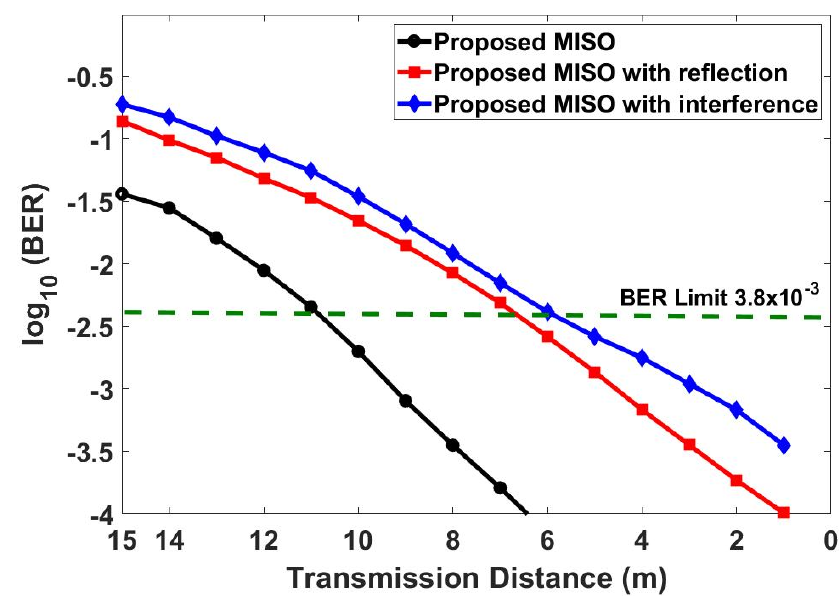
Figure 8. BER performance using 4 × 1 MISO processing for the cases when the receiver detects MIMO-encoded (i) LOS signal; (ii) LOS signal with a reflected version; (iii) LOS, reflected signal and an interference signal.